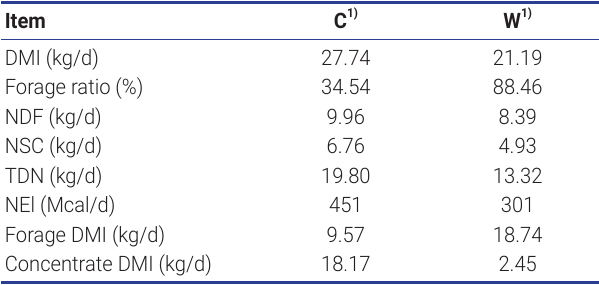
Table 2. Feed intake and nutrient composition of experimental ani- mals